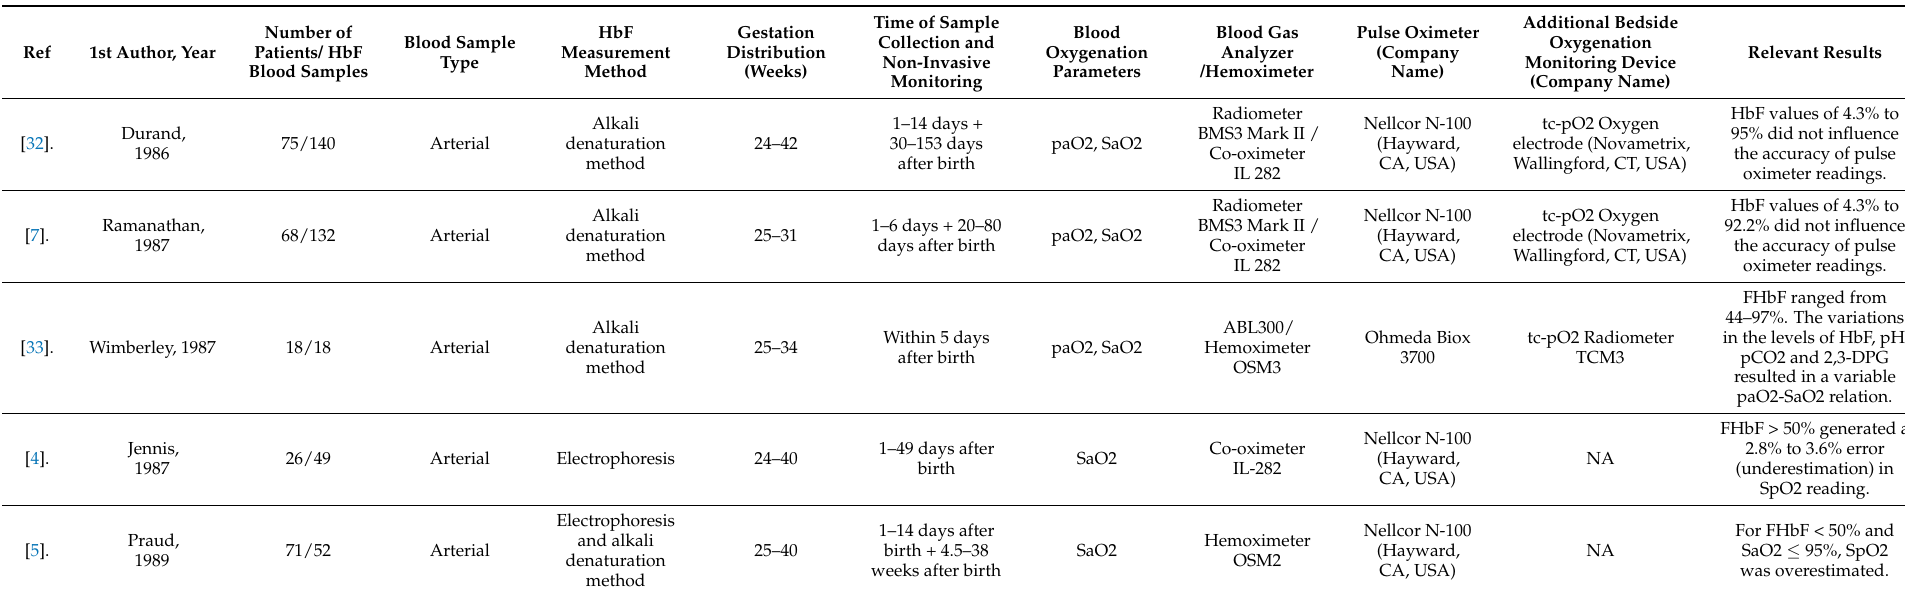
Table 1. Studies before 1992 comparing SpO2 monitoring to invasively measured blood oxygenation